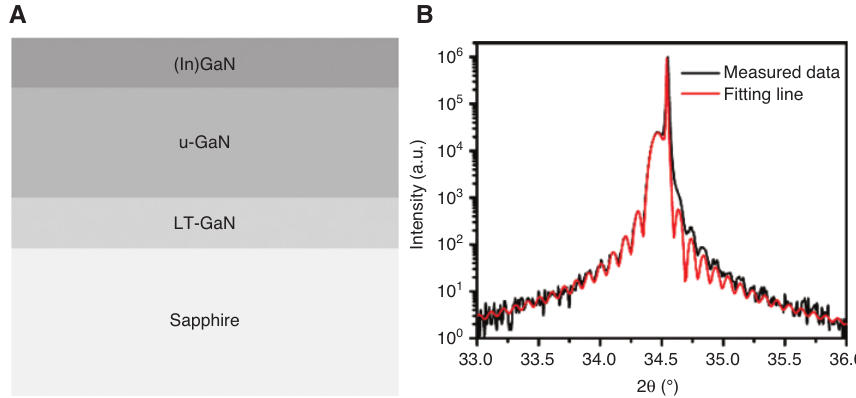
Figure 2: As schematically shown in (A), the reference sample structure is a thin unintentionally-doped GaN nucleation layer (LT-GaN), a 2 μ m-thick high-temperature grown GaN template (u-GaN) and a top u-InGaN layer. (B) Gives the ω -2 θ X-ray diffraction (XRD) rocking curves at (002) reflection of the u-InGaN waveguide layer, and the diffraction peaks located in the low and high angles of 2θ are originated from the InGaN and GaN layers,